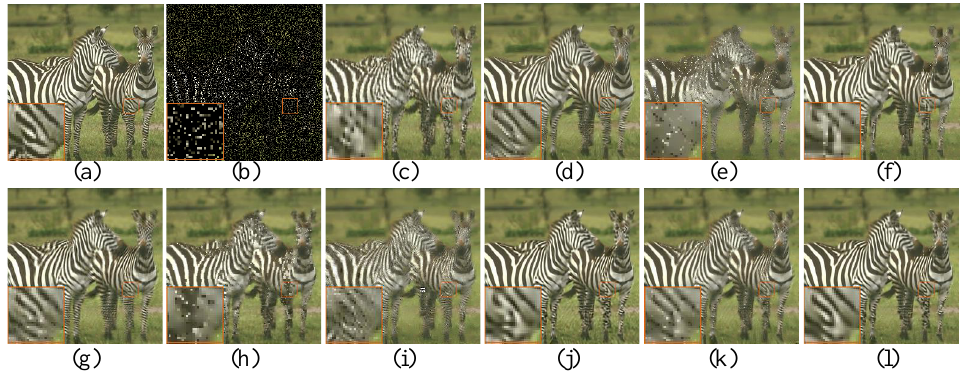
Figure 2. Visual comparison of Zebra by image inpainting with 80% missing pixels. ( a ) Original image; ( b ) Degraded image with 80% pixels missing; ( c ) BPFA [64] (PSNR = 20.90 dB, SSIM = 0.7160);